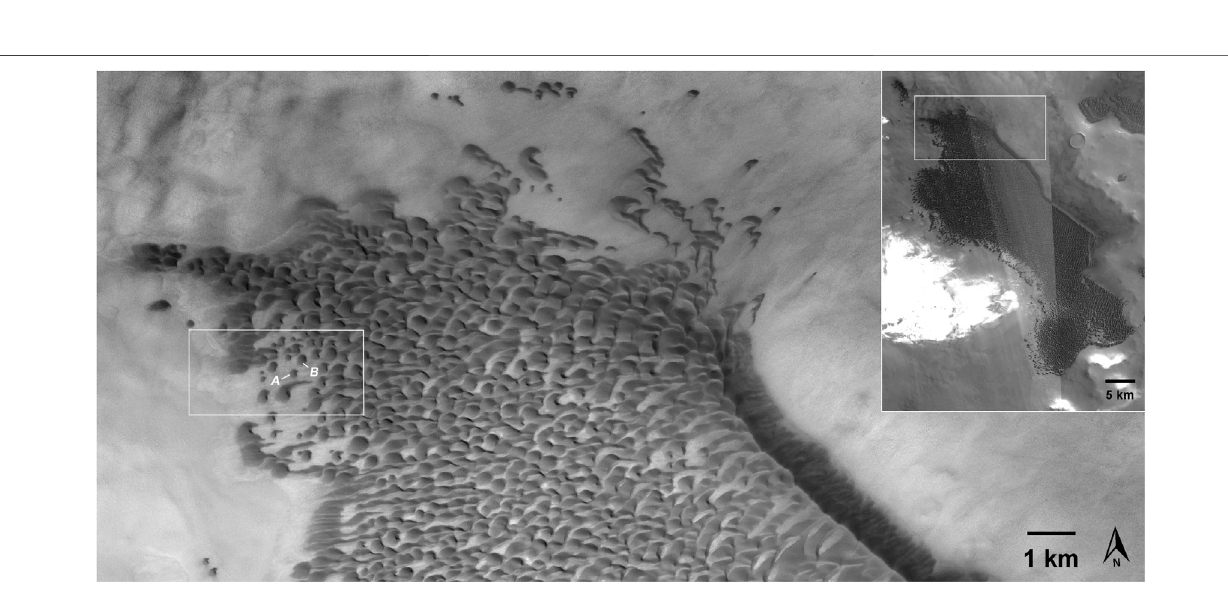
Frontiers in Earth Science |